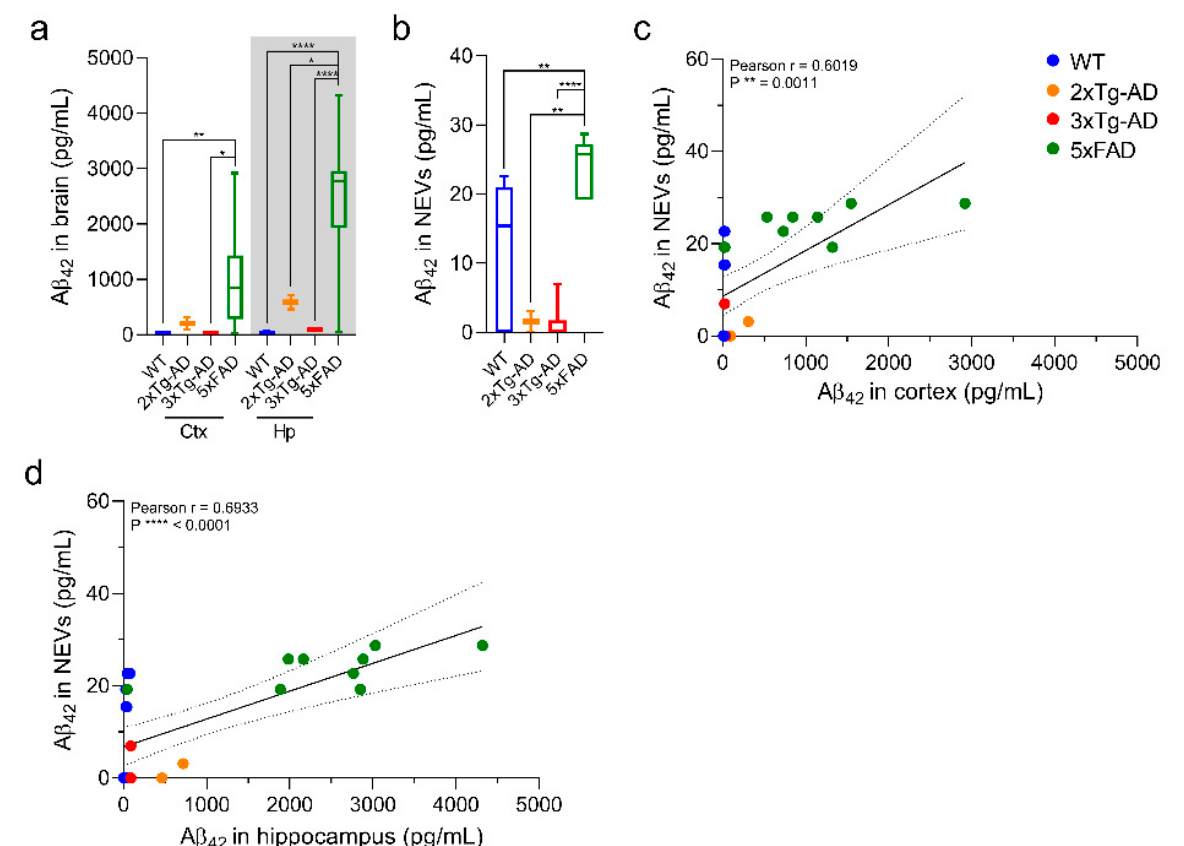
Figure 3. A β 42 levels in NEVs are positively correlated with brain levels. ( a , b ) Box-plots displaying human A β 42 protein levels in brains ( a ) and NEVs ( b ) of different AD mouse models and WT mice as measured by a Luminex-multiarray. Results show significantly increased levels of A β 42 in the brains and NEVs of 5xFAD mice compared to WT, 2xTg-AD and 3xTg-AD mice (one-way ANOVA; Ctx: ** p = 0.004 vs. WT mice and * p = 0.0104 vs. 3xTg-AD mice; Hp: **** p < 0.0001 vs. WT and 3xTg-AD mice, and * p = 0.0132 vs. 2xTg-AD mice; NEVs: ** p = 0.0023 vs. WT mice, ** p = 0.0021 vs. 2xTg-AD mice and **** p < 0.0001 vs. 3xTg-AD mice). N: 10 WT, 2 2xTg-AD, 6 3xTg-AD and 9 5XFAD. ( c , d ) Luminex-multiarray A β 42 levels in NEVs in relation to Ctx ( c ) and Hp ( d ) show statistically significant positive correlations as indicated by the Pearson correlation coefficient shown in each graph. All mice indicated in the methods section were included in the analysis and no outliers were identified.